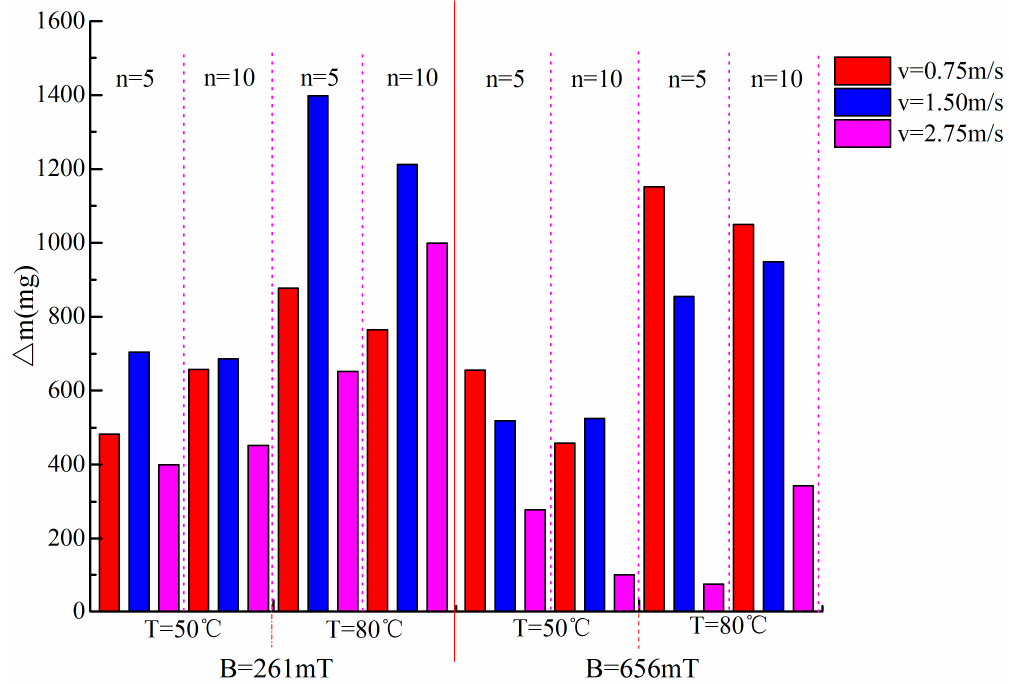
Figure 8. The ∆ m of the MW under different magnetization conditions (initial water temperature: 20 ± 0.1 °C).